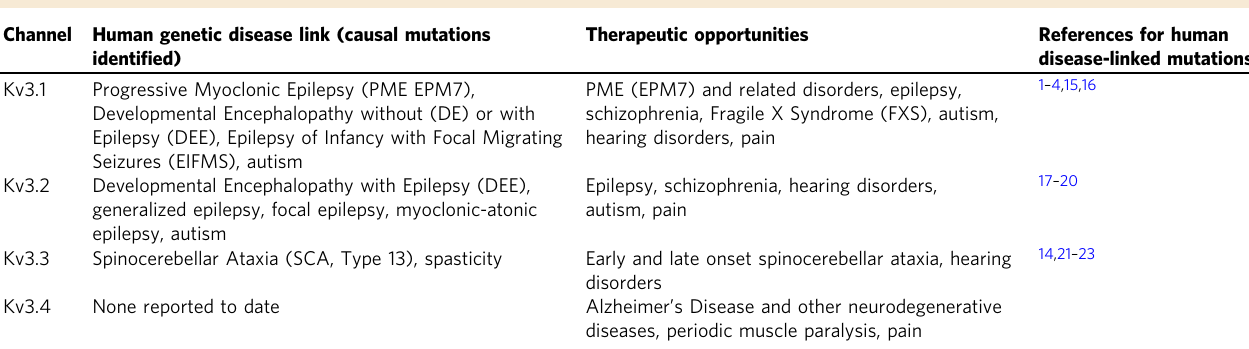
Table 1 Therapeutic potential for Kv3 channel